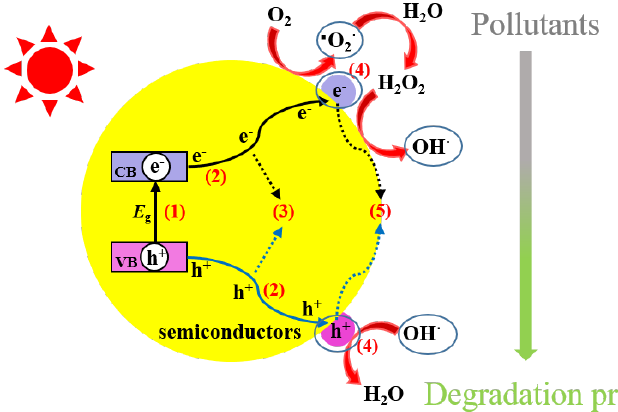
Figure 1. Photocatalytic processes over a heterogeneous photocatalyst.